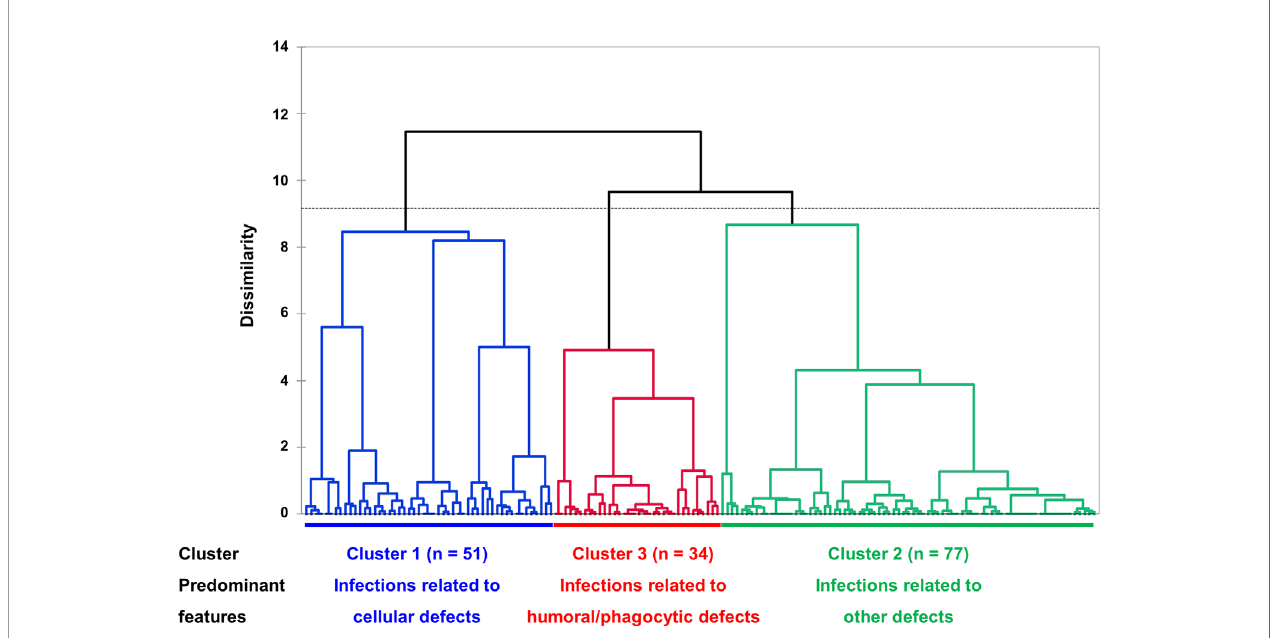
FIGURE 2 | Dendrogram of unsupervised hierarchical clustering. Three clusters, based on similarity of cases, were identi fi ed, and represented in different colors (cluster 1, blue, infections related to cellular immunity defects; cluster 2, green, infections related to other immunity defects; cluster 3, red, infections related to humoral and phagocytic immunity defects). The vertical axis represents a measure of dissimilarity. In the horizontal axis, each patient is represented by a vertical line starting at the bottom and progressively merge with other patients to form clusters. Dashed line indicates the cut-off point for the three